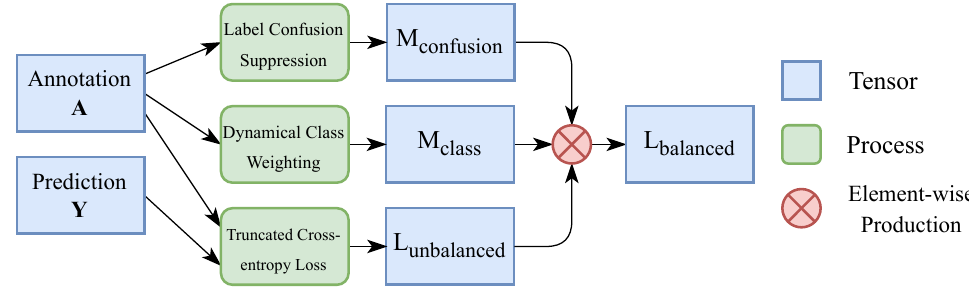
Figure 5. A flowchart of the balanced loss for segmentation that combines dynamical class weighting, truncated cross-entropy loss, and label confusion